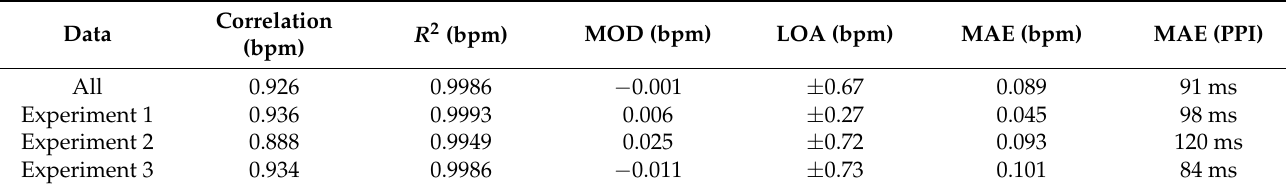
Table 1. Performance results for the overall data and each of the three